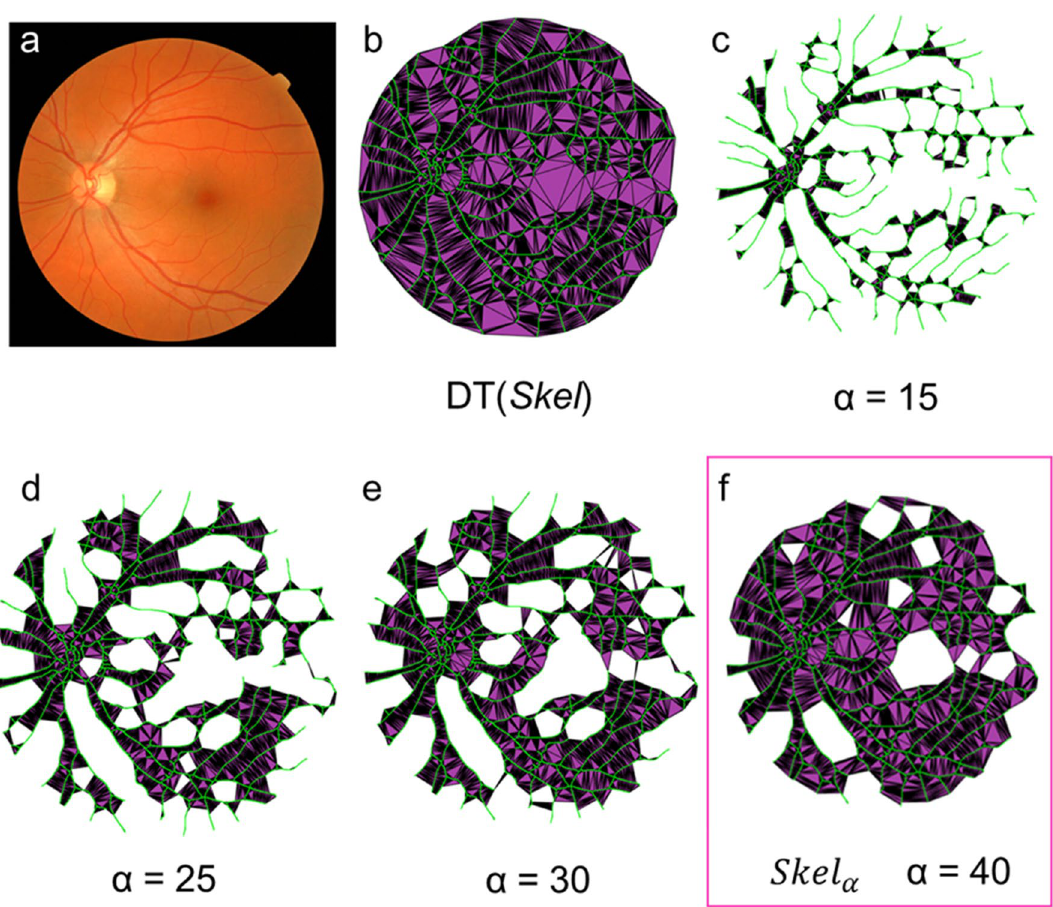
Figure 1. Representing the retinal microvasculature as a 2D alpha-shape. Controlling the level of refinement (α) from the vessel skeleton (green) of a colour fundus photograph (a) in the MESSIDOR dataset (Grade 0). ( b) DT ( Skel ) encompasses all points of the skeleton. (c–e) As α is increased more of the simplices in DT ( Skel ) are included into the α-shape (purple), (f) until there is a minimum value of α that encompasses all points of the vasculature giving a single region and a representation of the vessel